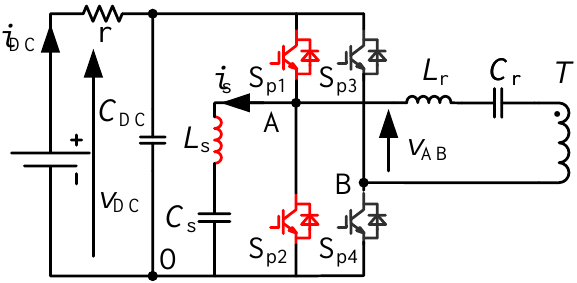
Figure 6. The integrated buck/boost stage at the primary side of the HF transformer for power decoupling.